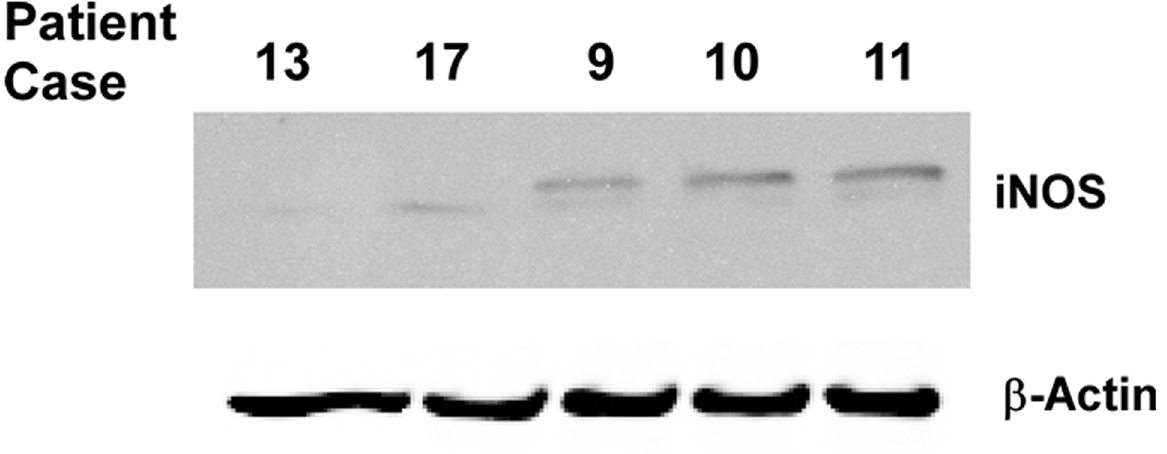
Fig 2. Analysis of iNOS protein levels in TNBC patients by